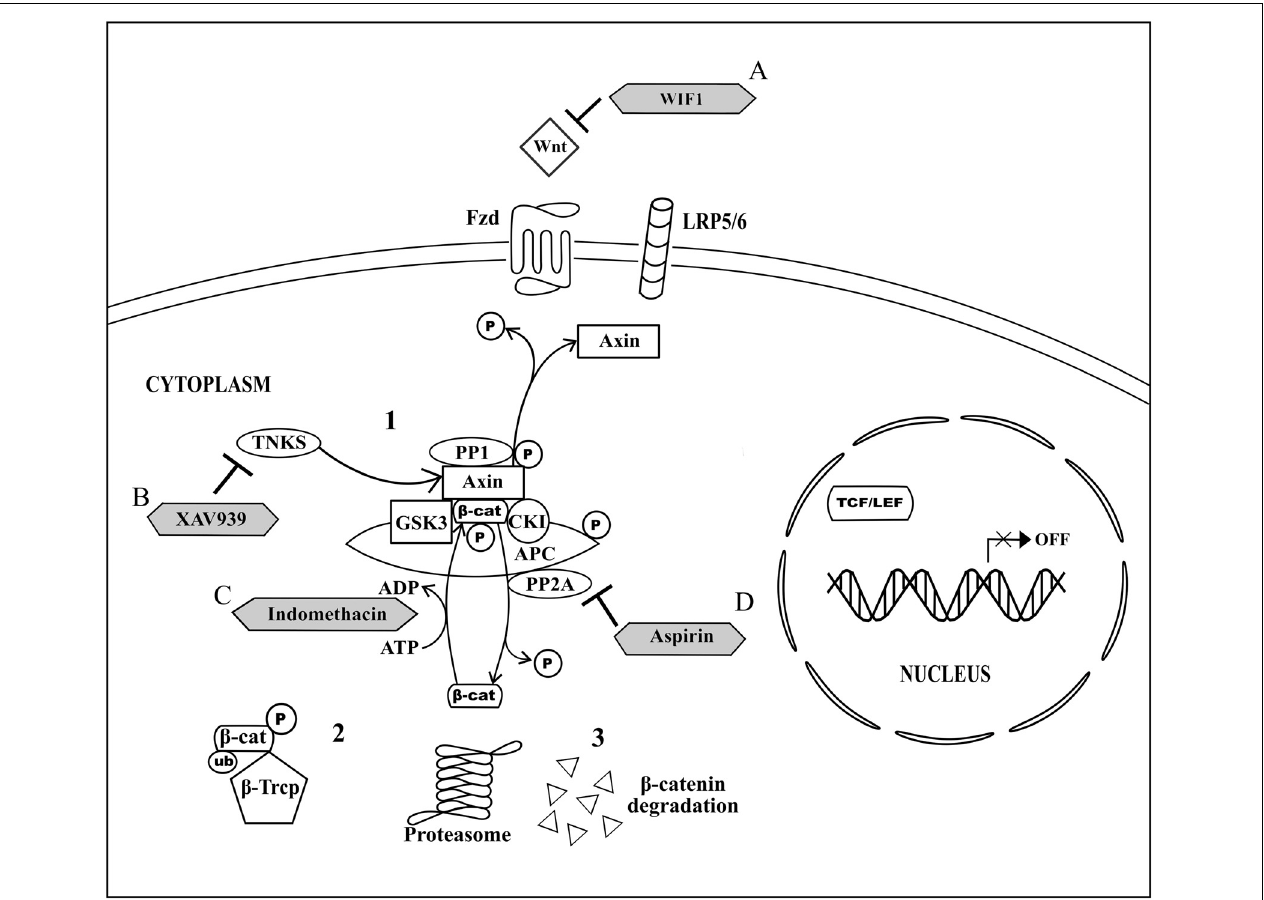
FIGURE 1 | Non-activated canonical Wnt signaling pathway and the drug targeted components. (1) In the absence of Wnt signaling transduction, Axin, GSK3, CK1, and APC form a multiprotein destructive complex to promote β -catenin phosphorylation. In the negative feedback regulation, PP1 promotes dephosphorylation of Axin and subsequent disassembly of multiprotein destructive complex, whereas PP2A binds to Axin and/or APC and directs β -catenin dephosphorylation. (2) β -Trcp binds to the phosphorylated β -catenin for β -catenin ubiquitination. (3) Proteasomal degradation of the ubiquinated and phosphorylated β -catenin results in cytoplasmic β -catenin destruction. (A) WIF1 directly binds to Wnt for inhibition of Wnt binding to Fzd. (B) XAV939 inhibits activity of TNKS and thus promotes Axin upregulation. (C) Indomethacin promotes β -catenin degradation by phosphorylating β -catenin. (D) Aspirin acts as an inhibitor for negative feedback regulation modulated by PP2A and eventually directs β -catenin